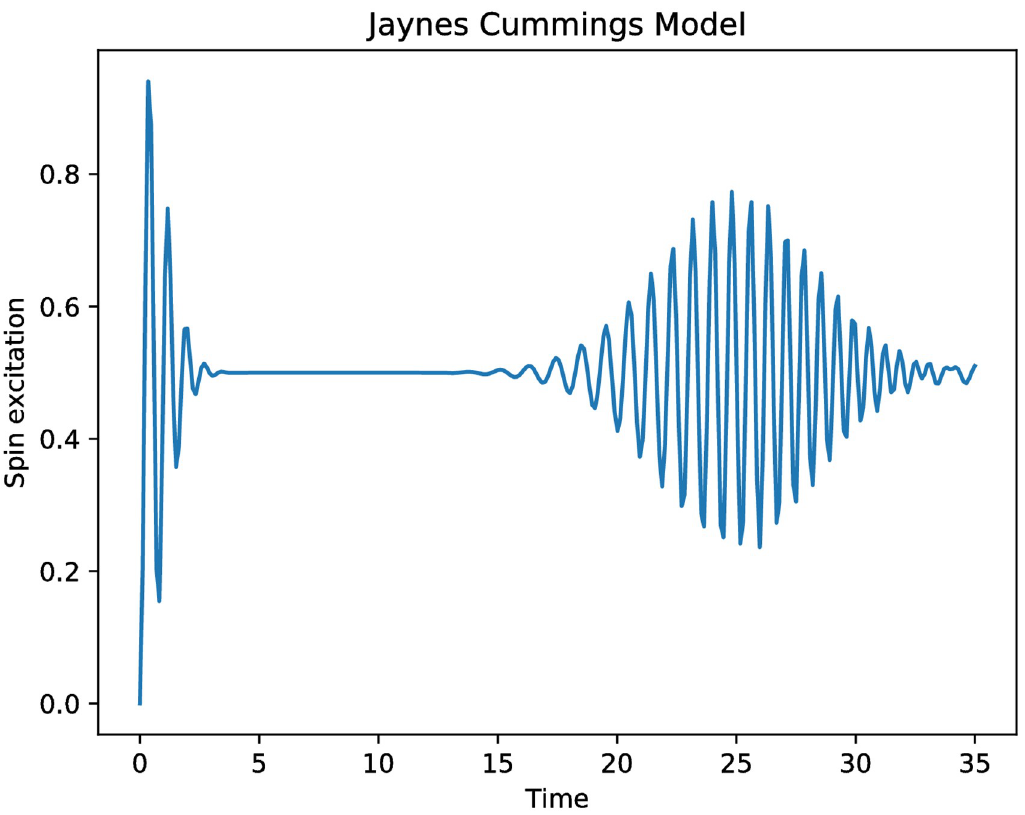
Fig 8. The values of the spin excitation in the JCM obtained after calculating one trajectory without using collapse operators.